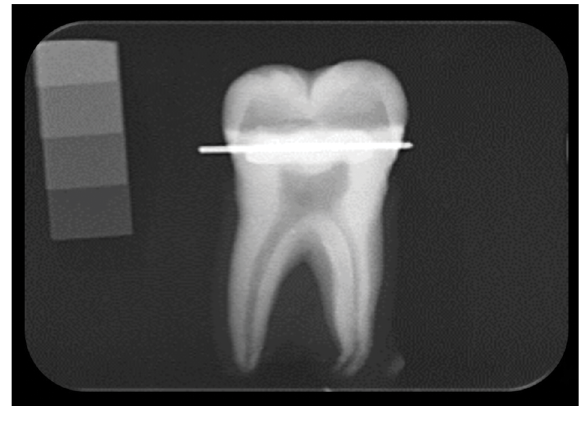
Figure 1. Periapical radiography used to control the depth of cavity preparation. Note the orthodontic steel wire (the more radiolucent object) helping to determine approximately 1 mm of remaining dentin between the occlusal surface and the pulp chamber